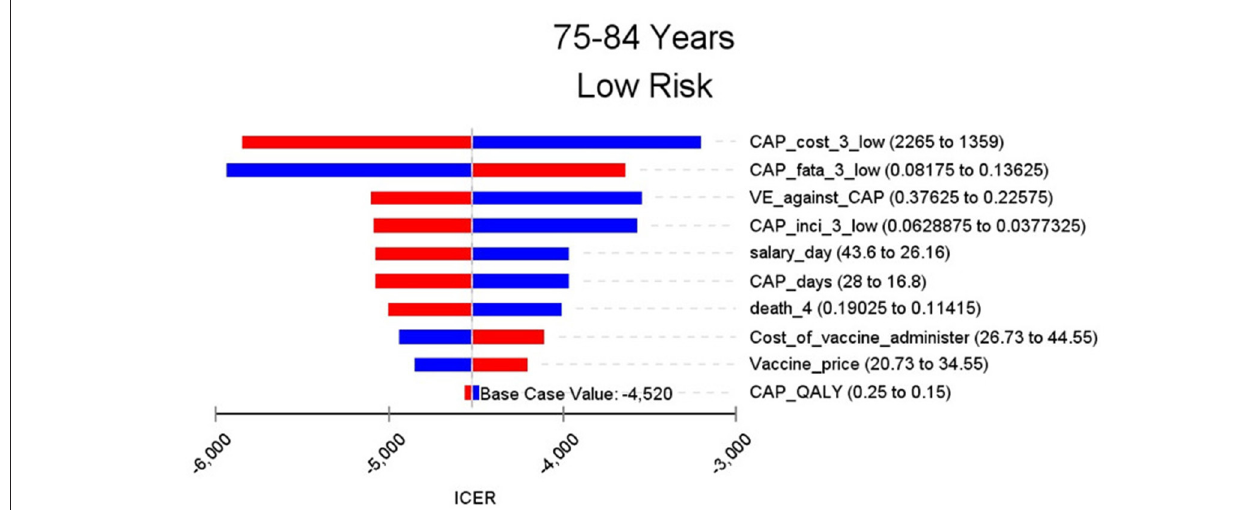
FIGURE 6 | Sensitivity analysis in group 75–84 years and low risk.